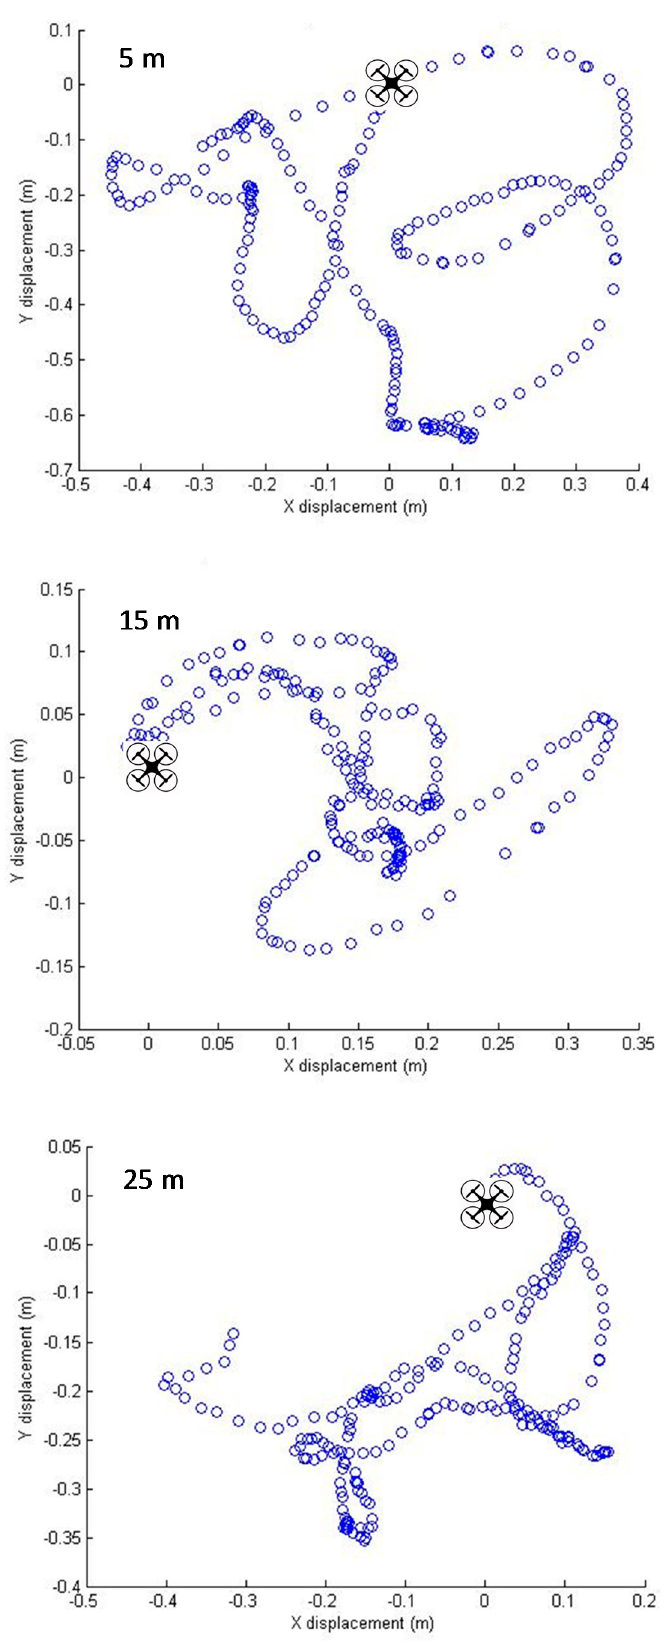
Figure 9. 3DR Iris+ position displacement during hovering test using image processing.